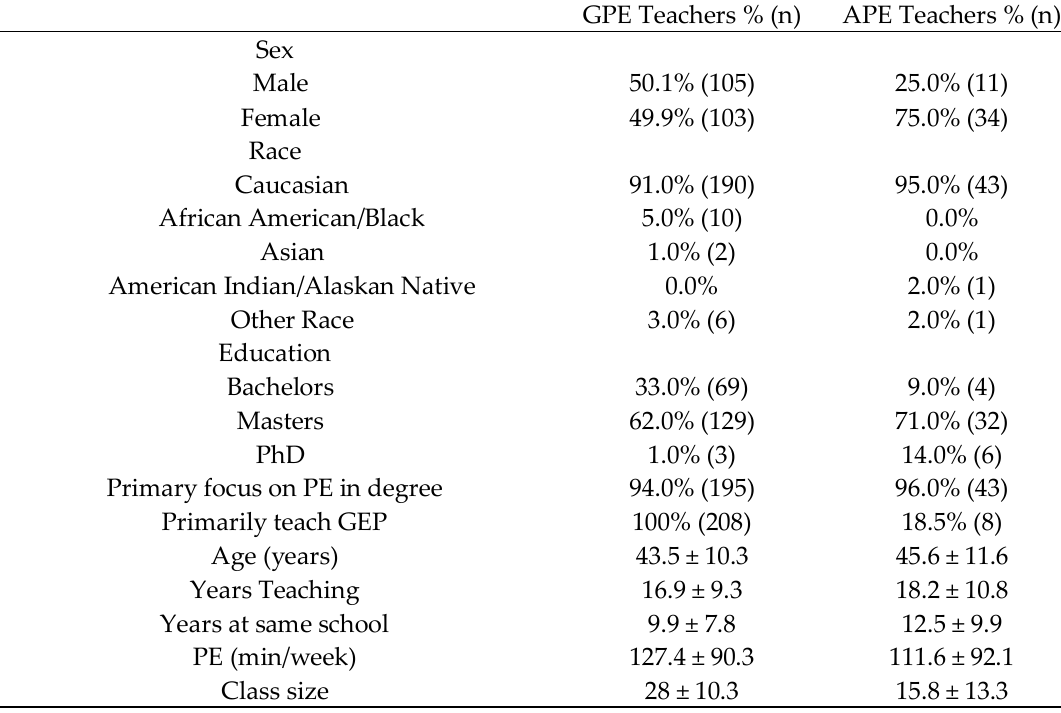
Figure 1. Integrated Theoretical Framework Table 1. Demographic Characteristics of